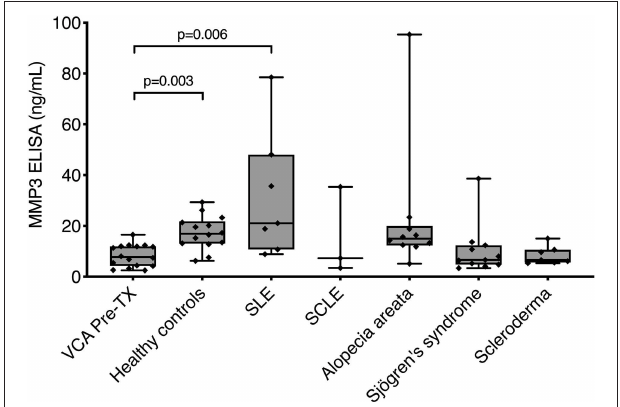
FIGURE 3 | MMP3 levels in healthy controls and patients with autoimmune skin disease. Serum levels of MMP3 were measured in healthy controls ( n = 14) as well as in patients with systemic lupus erythematosus (SLE, n = 7), subacute cutaneous lupus erythematosus (SCLE, n = 3), alopecia areata ( n = 10), Sjögren’s syndrome ( n = 11), and limited cutaneous scleroderma ( n = 7). When comparing to pre-transplant (Pre-TX) levels of VCA patients, there was